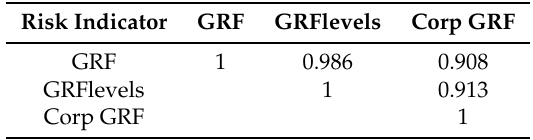
Table 15. Correlations between alternative GRF